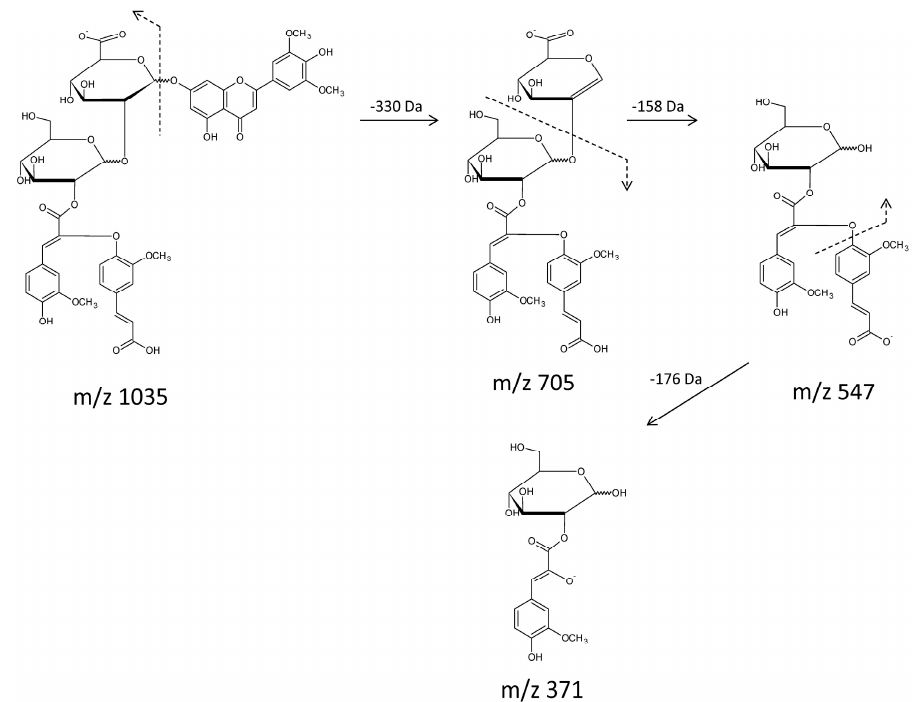
Figure 5. Proposed fragmentation pathway for compound 34 based on MS/MS spectrum registered in negative ion mode.